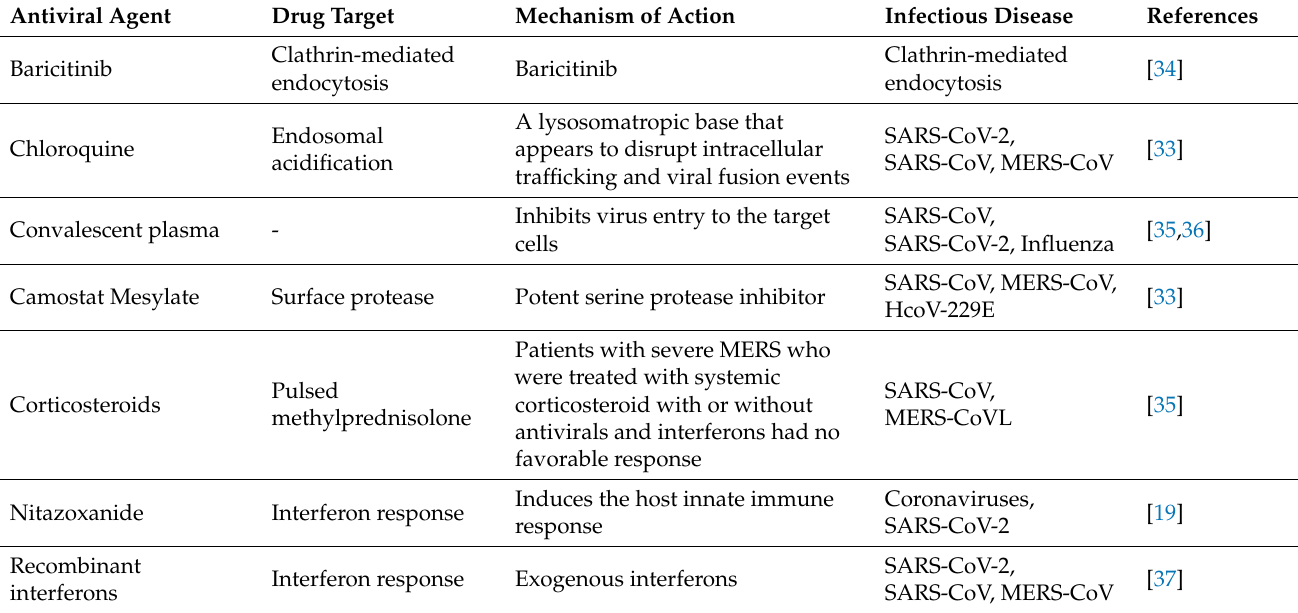
Table 2. Host-based therapy: Drug target and mechanism of action against infectious diseases. Antiviral